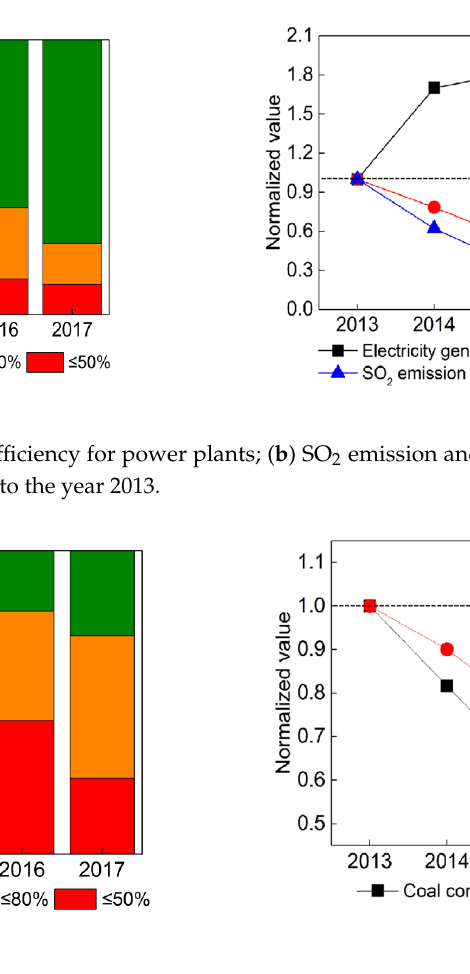
Figure 5. Trends in ( a ) desulfurization efficiency for industrial boilers (capacity ≥ 10 t/h); ( b ) SO 2 emission and coal consumption for industrial combustion, the related data were normalized to the year 2013.